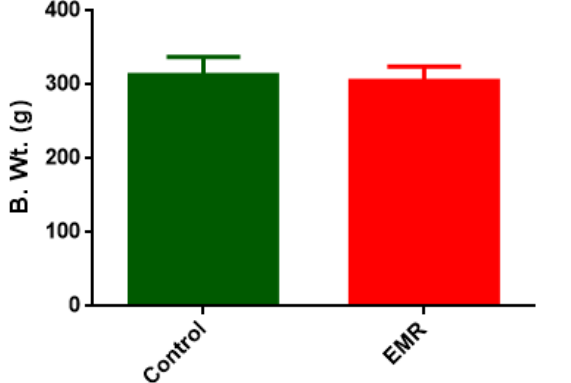
Figure 2. Effect of 150 kHz IF EMR on mean body weight of SD rats after 2-month whole-body exposure.